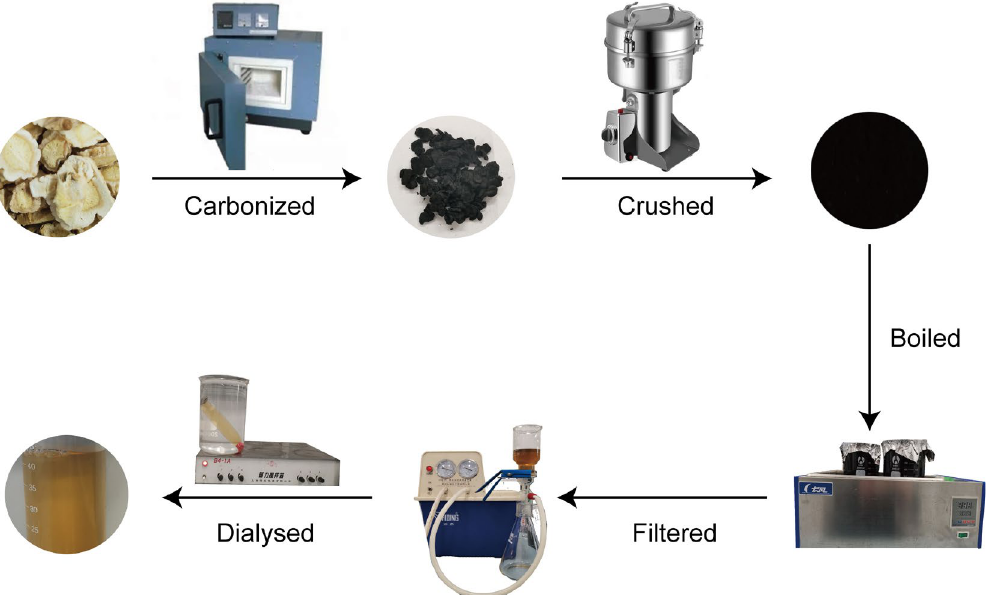
Figure 9. Preparation flow chart of PGC - CDs.